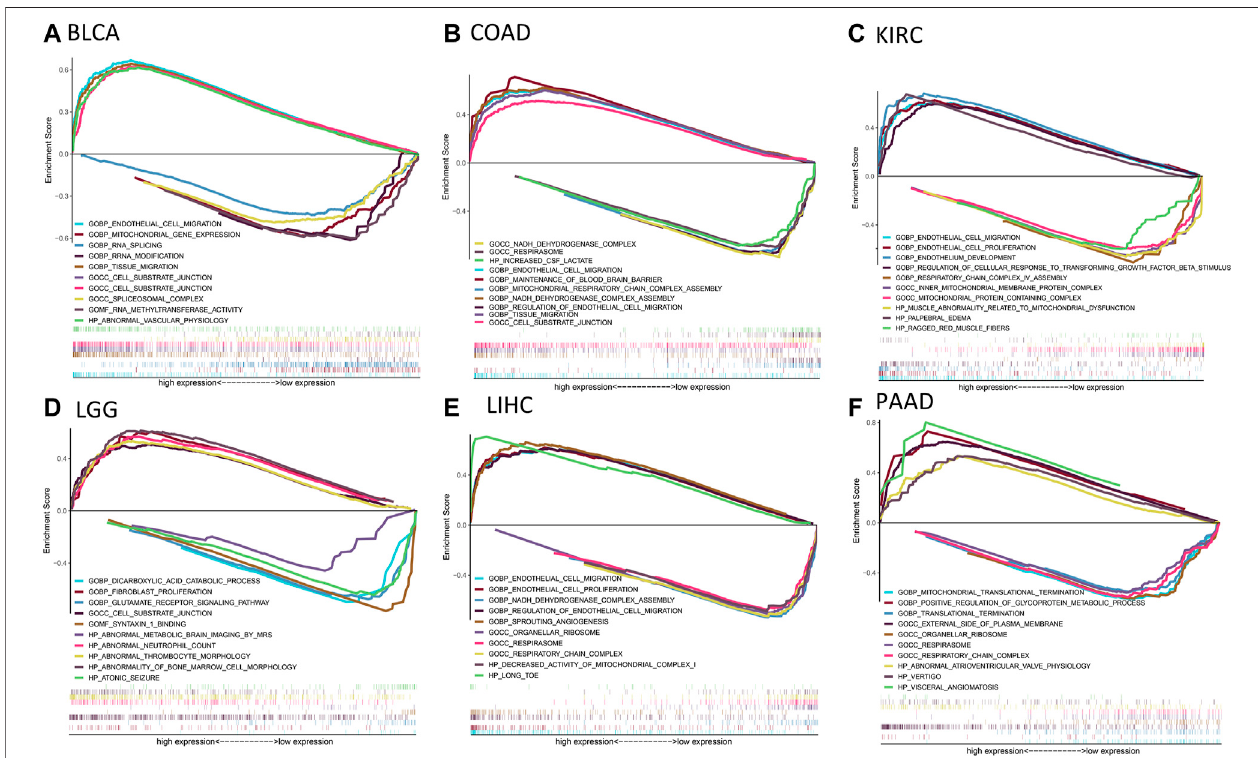
FIGURE 7 | Results of gene set enrichment analysis (GSEA) based on the Gene Ontology (GO) database. (A – F) : The GSEA analysis between CD93 high and low expression group in BLCA, COAD, KIRC, LGG, LIHC and PAAD. The left and right sides of each panel represent the enriched pathways of the CD93 high and low expression group,